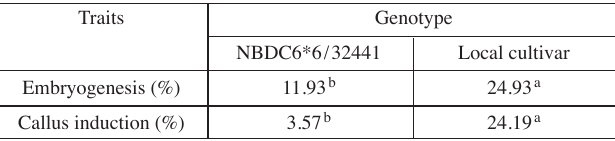
Tab. 4: Effects of genotypes on embryogenesis and callus induction in experiment